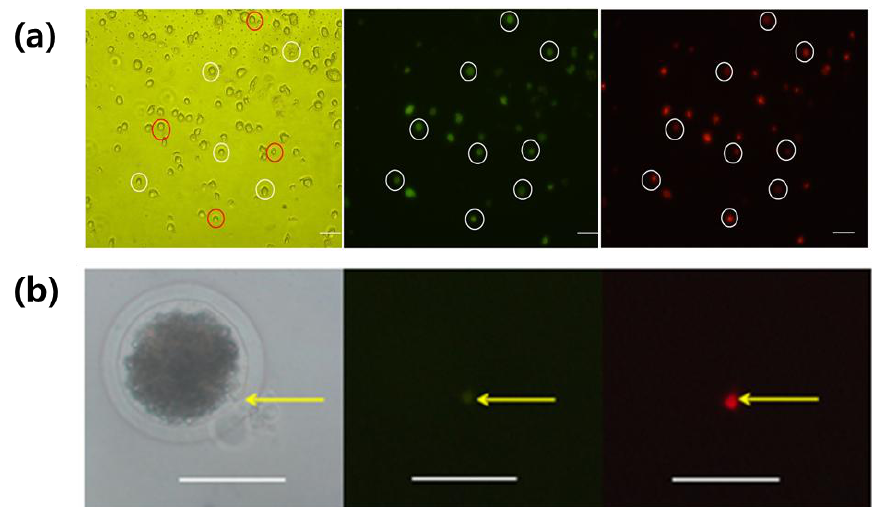
Figure 2. Somatic cell nuclear transfer with ZFN-treated donor cells. (a) Cells with intact membrane (circled in red) expressing both eGFP and RFP simultaneously (circled in white) were selected as donor cells (scale bar = 200  m). (b) A manually-selected donor cell (arrow) was fused with a porcine oocyte matured in vitro (scale bar = 100  Table 1. In vitro culture of cloned embryos derived from ZFN- treated donor cells